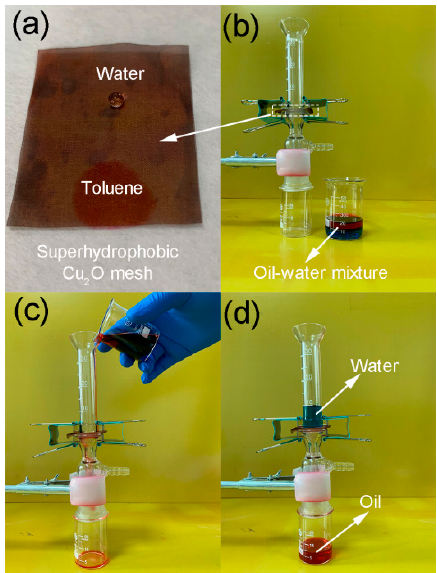
Figure 5. ( a ) Water and oil on the surface of the superhydrophobic Cu 2 O mesh, ( b ) separation device and oil–water mixture (toluene was dyed with oil red O and water was dyed with methylene blue), ( c ) and ( d ) oil–water separation process.